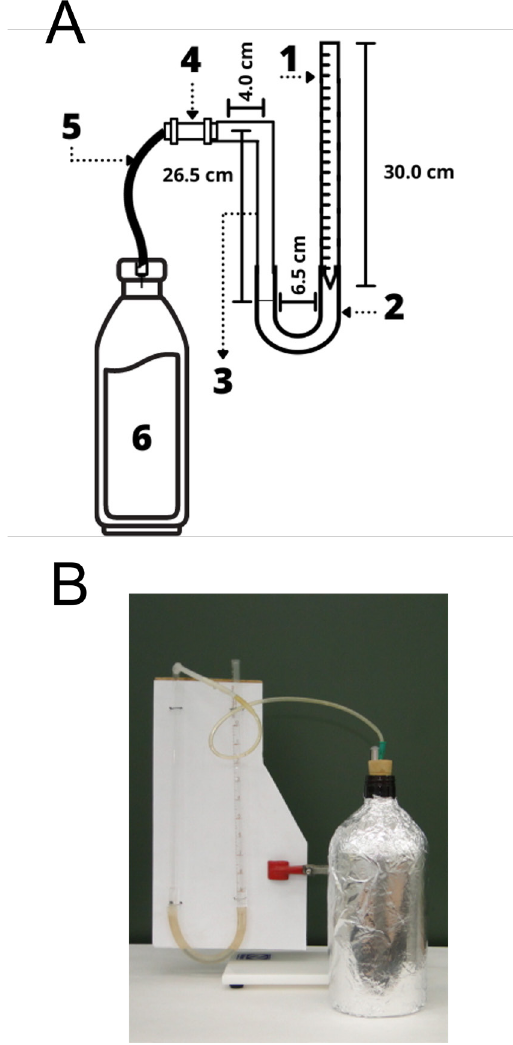
Figure 1. (A) The manometric system to evaluate the daily mineralization rates, and its components: 1) Graduated pipette (vol. 10 ml); 2) Flexible plastic tube (internal diameter: 0.5 cm); 3) Glass tube (external diameter: 0.5 cm); 4) Two ways plastic adapter*; 5) Transparent flexible plastic tube (internal diameter ca. 1 mm)*; 6) Reagent bottle (volume: 1 liter). (*) components present in the gravitational parenteral infusion set. (B) Picture of the manometer attached to the reaction